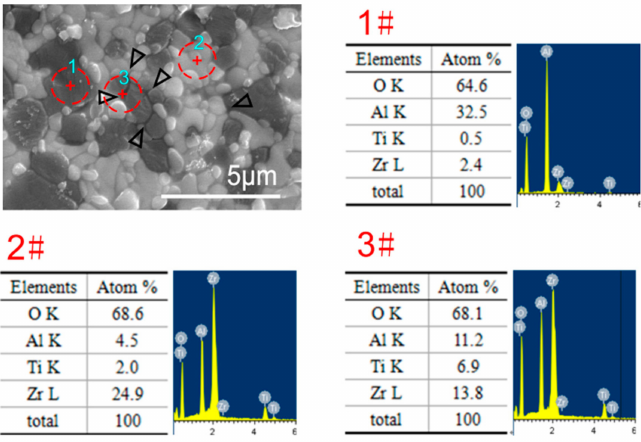
Figure 4. Microstructure and EDS analysis (1# is Al 2 O 3 , 2# is ZrO 2 , and 3# is liquid phase).